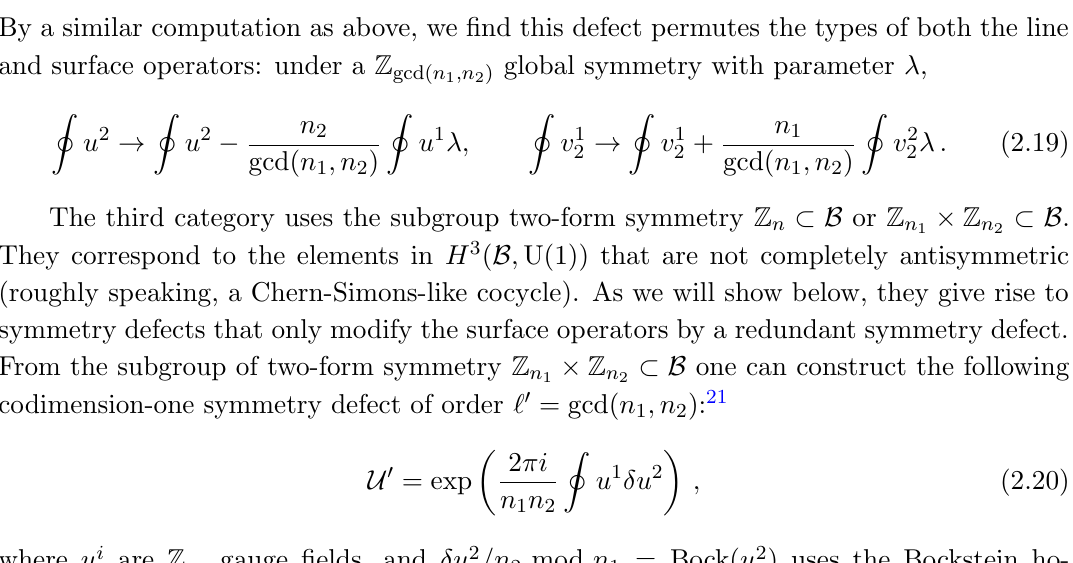
Figure 2 . Sliding the 0-form symmetry defect (2.20) (denoted by the solid black lines) across the junction of three surface operators (denoted by the red dashed lines) produces an additional symmetry line defect at the junction (denoted by the blue dot). The 0-form symmetry defect acts on the surface operators on the lower side of the solid black line in the (cid:12)gure as in